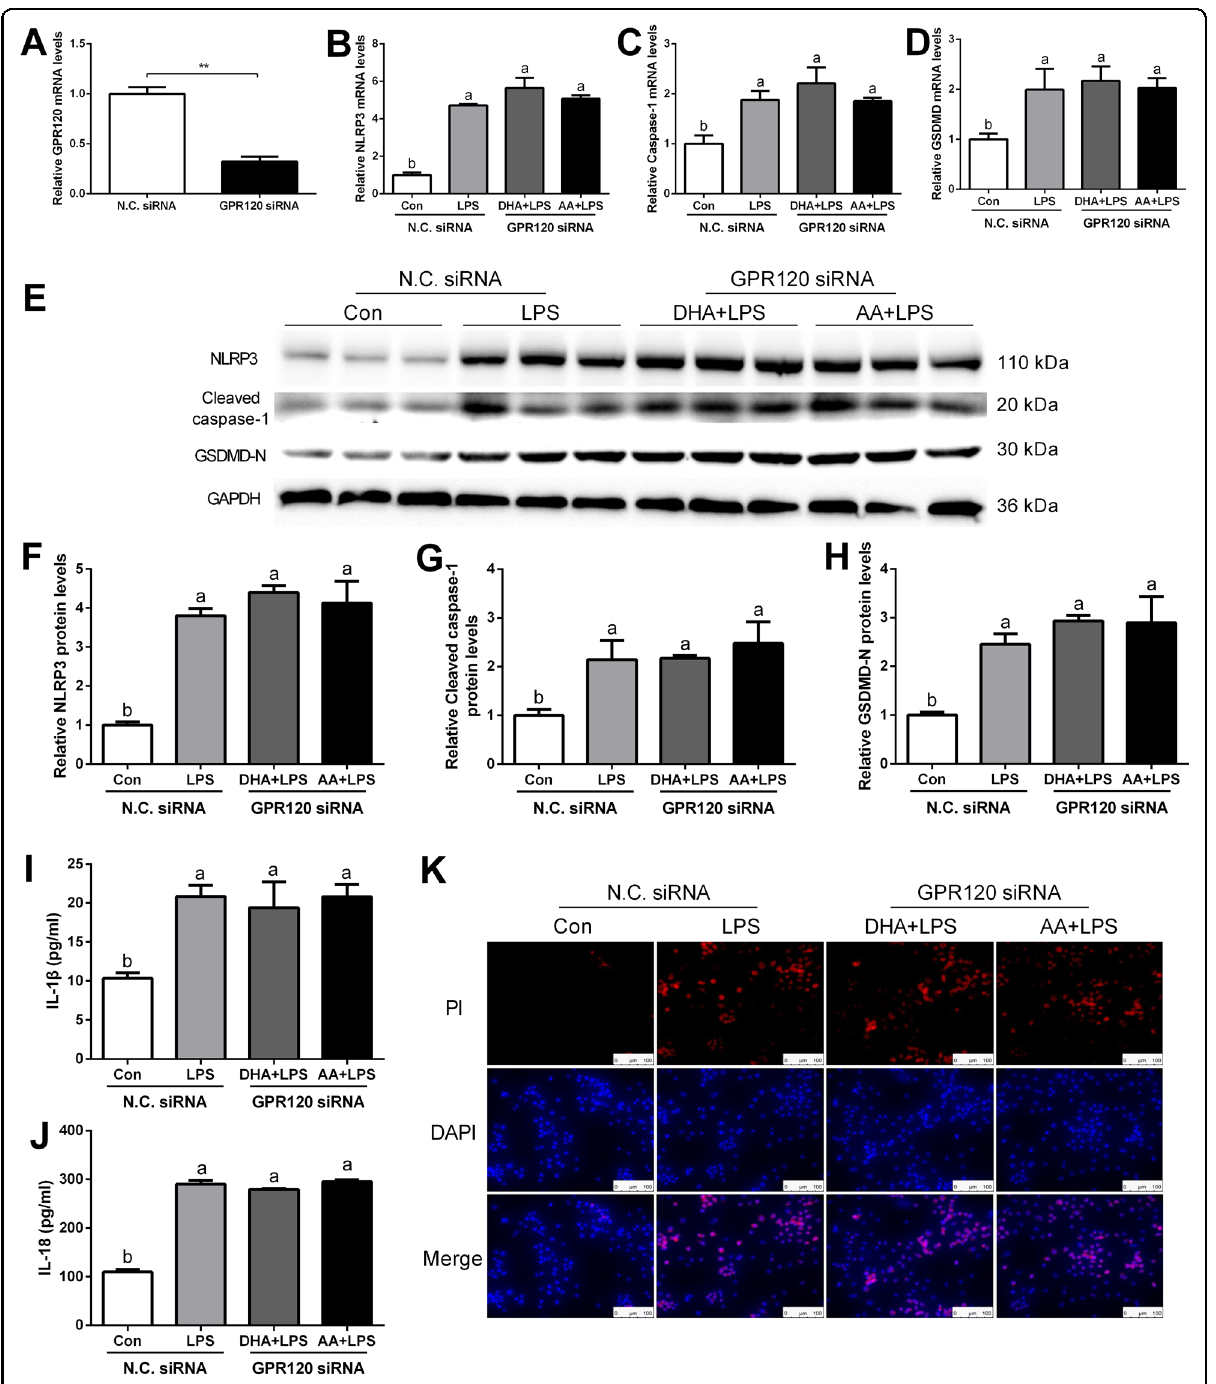
Fig. 3 Silencing GPR120 abolished the inhibition of pyroptosis by DHA and AA in LPS-induced Kupffer cells. GPR120 siRNA was transfected into Kupffer cells for 24 h. A – D mRNA levels of GPR120, NLRP3, caspase-1, and GSDMD were determined by quantitative real-time PCR. E – H Protein levels of NLRP3, caspase-1, and GSDMD were determined by western blot analysis. I , J Levels of IL-1 β and IL-18 in the supernatant were measured by ELISA; K PI staining was used in immuno fl uorescence (scale bar, 100 μ m). In the bar graph, data represent the means ± SEM, n = 3 per group. Mean values not sharing the same letters are signi fi cantly different, P < 0.05; ** P <